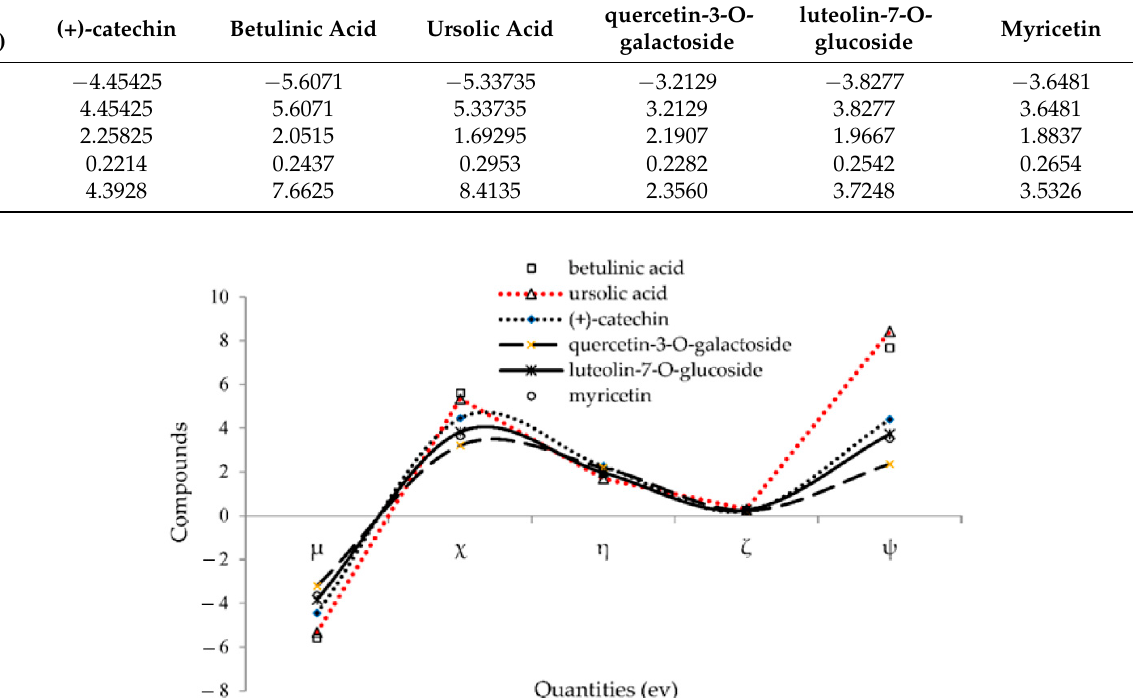
Table 4. Chemical potential ( µ ), electronegativity ( χ ), hardness ( η ), softness ( ζ ), electrophilicity index ( ψ ) for (+)-catechin, betulinic acid, ursolic acid, quercetin-3-O-galactoside, luteolin-7-O-glucoside, and myricetin.